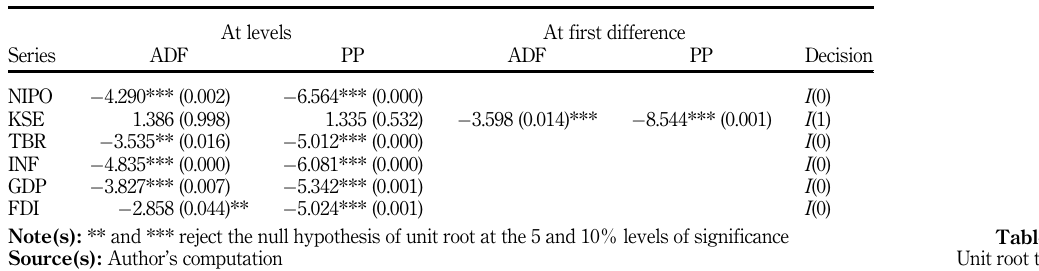
Table 3. Unit root